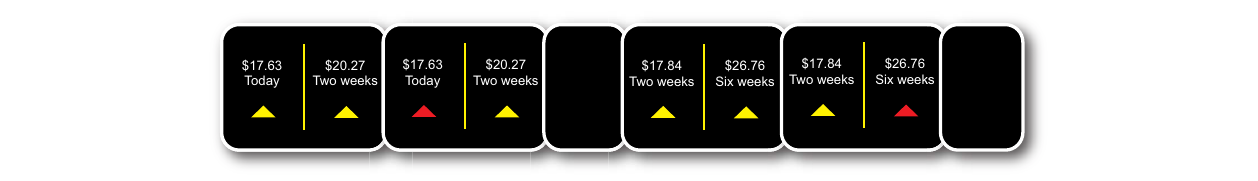
FIGURE 1 |Two sample trials of the intertemporal choice task. Subjects viewed two options, selected one via button press, and their choice was highlighted on the screen.